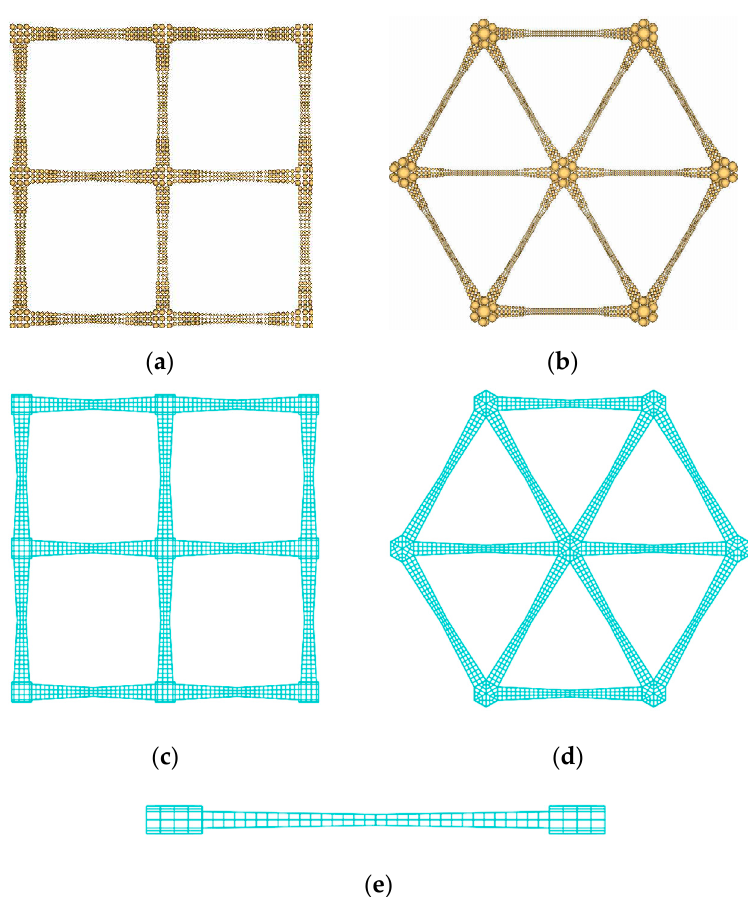
Figure 2. Comparison of geogrid models: ( a ) DEM biaxial geogrid; ( b ) DEM triaxial geogrid; ( c ) FDM biaxial geogrid; ( d ) FDM triaxial geogrid and ( e ) FDM geogrid rib from a side view.